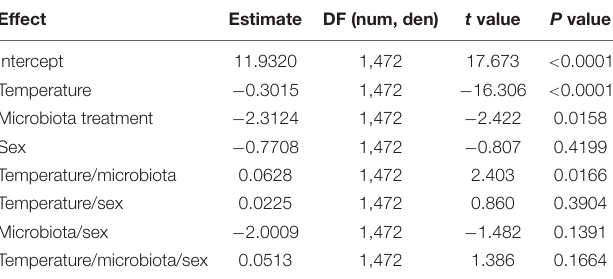
TABLE 1 | Results of linear model testing effects of the assayed temperature, microbiota treatment, and sex on the heat tolerance (measured as the knockdown time in static assays) of Drosophila subobscura